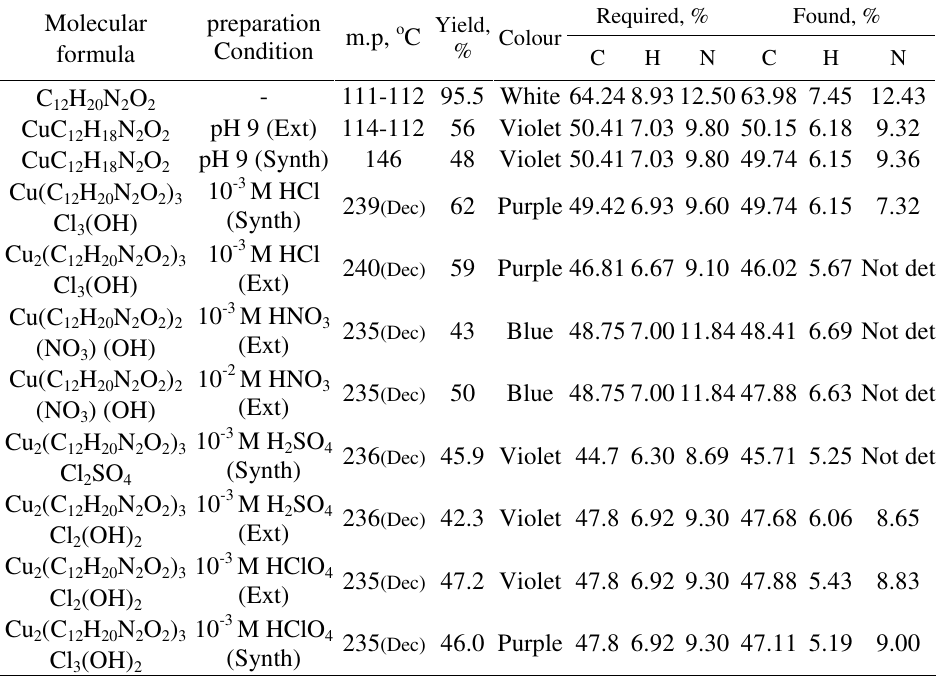
Required, % Found, % Molecular